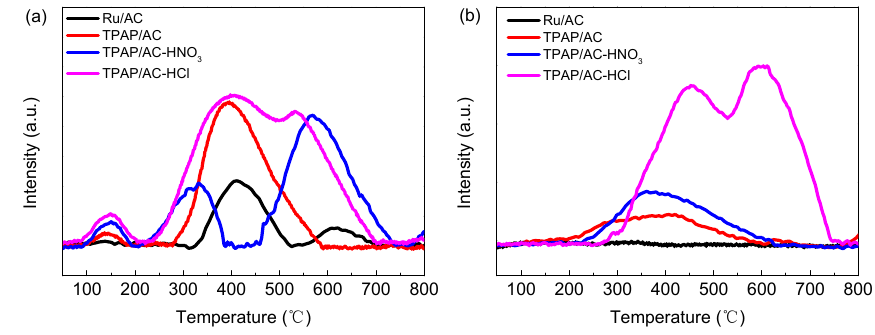
Figure 7. C 2 H 2 ‐ ( a ) and HCl ‐ ( b ) TPD profiles of the fresh Ru ‐ based catalysts. Figure 7. C 2 H 2 - ( a ) and HCl- ( b ) TPD profiles of the fresh Ru-based